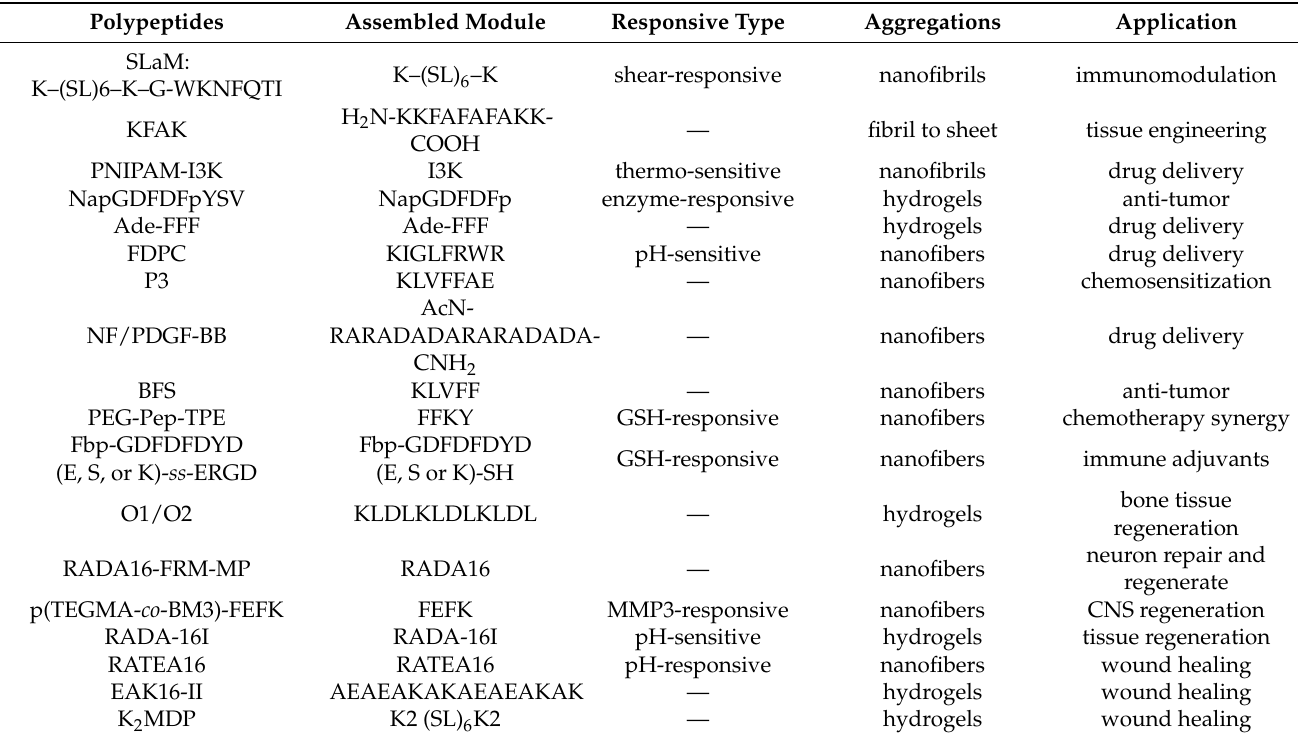
Table 1. Some representative self-assembled polypeptides applied in medicine discussed in this paper.